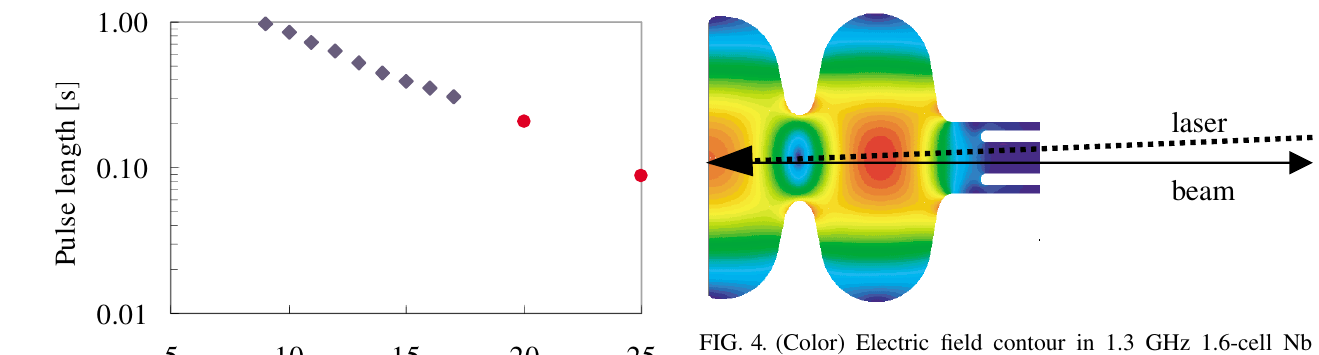
FIG. 4. (Color) Electric field contour in 1.3 GHz 1.6-cell Nb cavity with coaxial input coupler. Laser beam illuminates the back . n